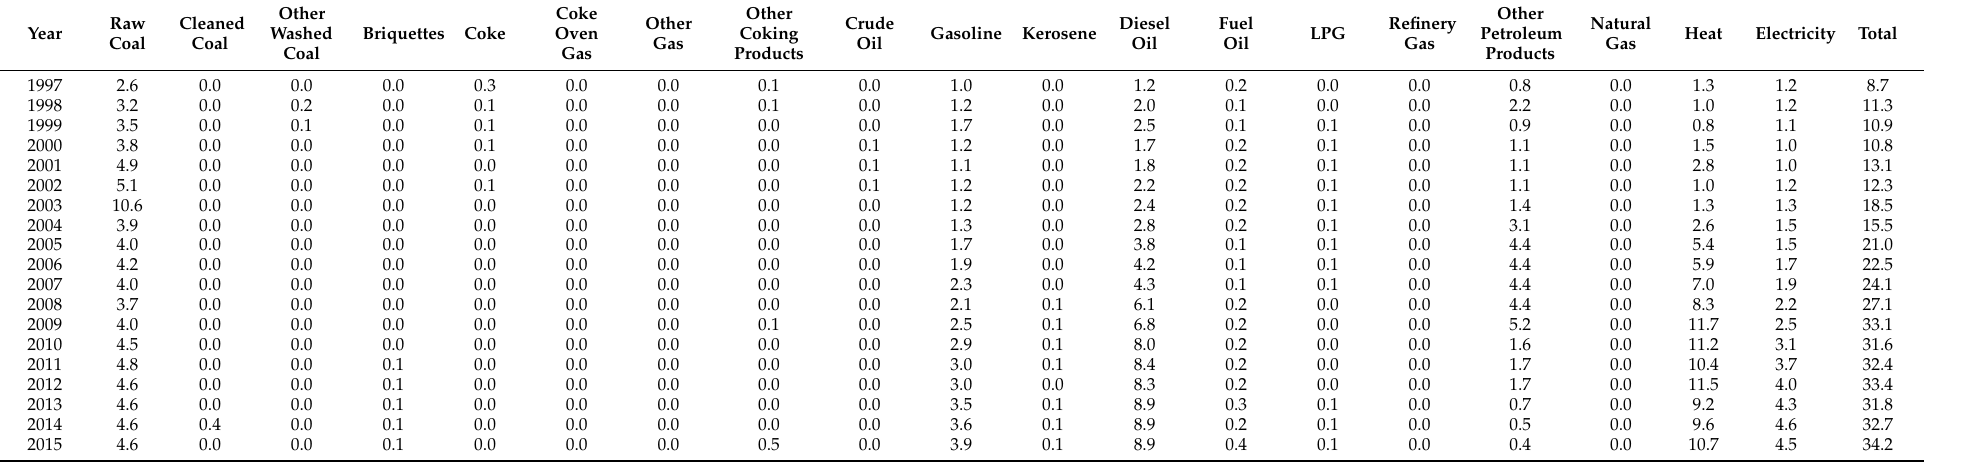
Table 5. National Chinese construction industry CO 2 emissions based on UN China emission factors (MtCO 2